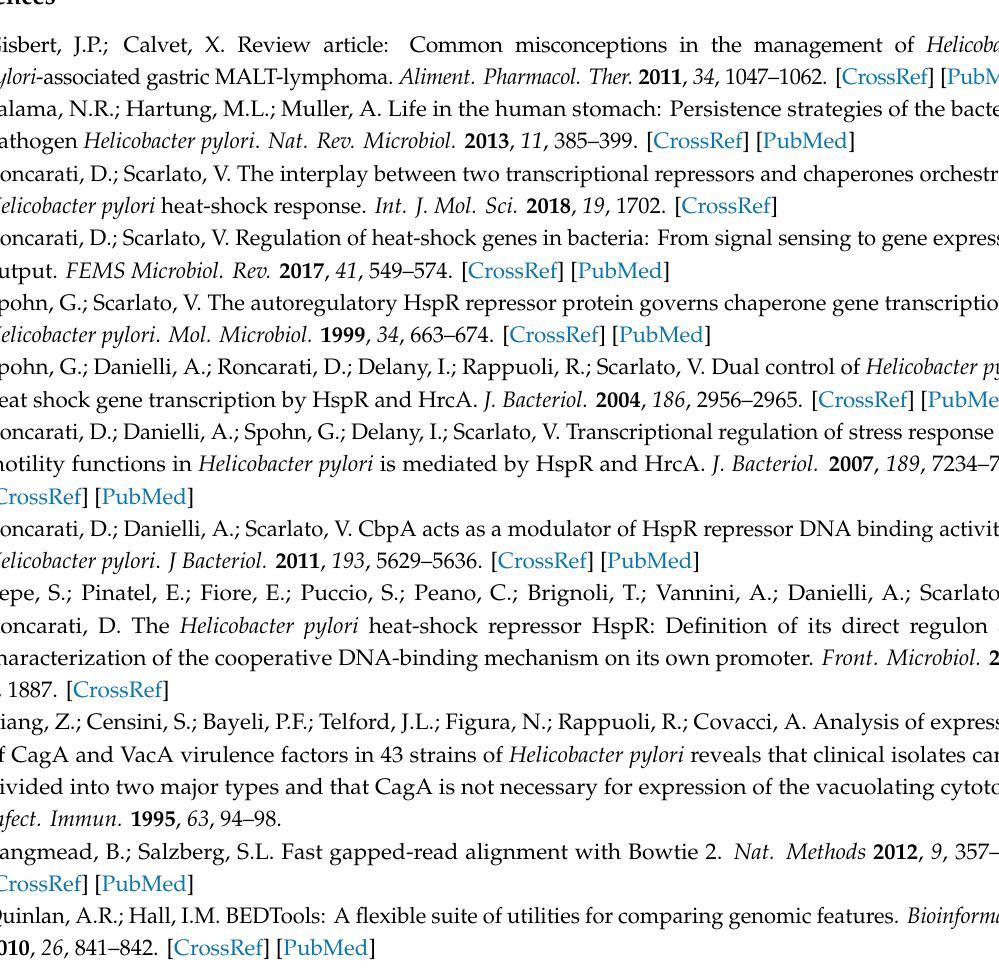
Table S1: List of oligonucleotides used in this study, Table S2: Extended table of up- and down-regulated